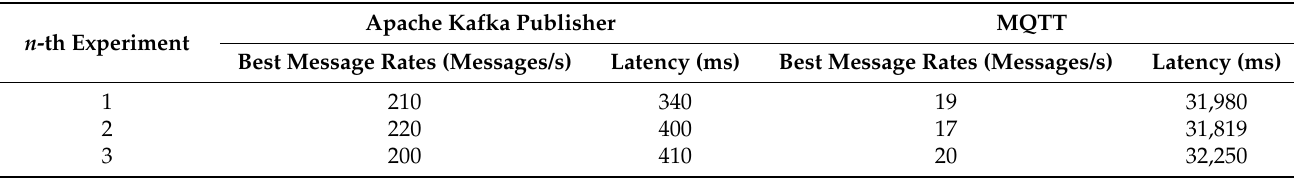
Table 3. Performance comparison of the Apache Kafka Pub protocol and the MQTT protocol.